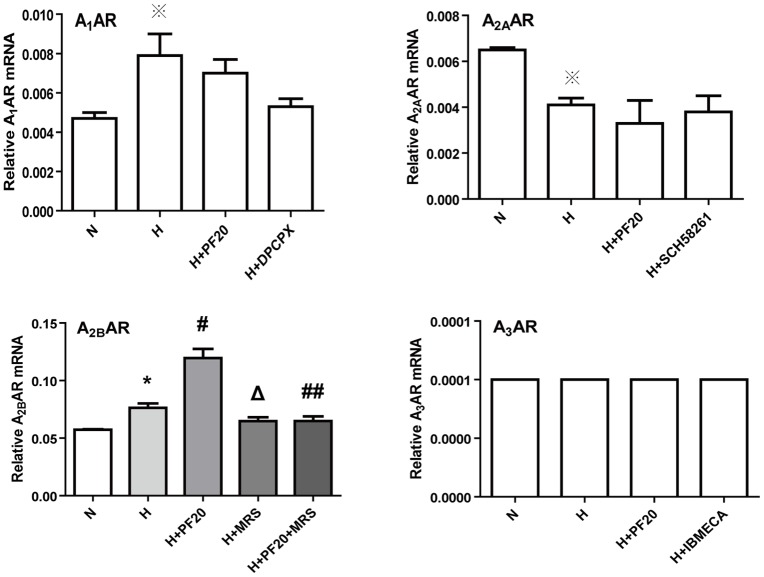
Effects of hypoxia and paeoniflorin on the expression of adenosine receptors.The PASMCs were incubated under normoxic (N), hypoxic (H) condition, or pretreated with PF (20 μmol/l) when under hypoxic condition. ※ P>0.05 vs. the N group; * P<0.05 vs. the N group; # P<0.05 vs. the H group; ## P<0.05 vs. the H+PF20 group; Δ P<0.05 vs. the H group n = 3.